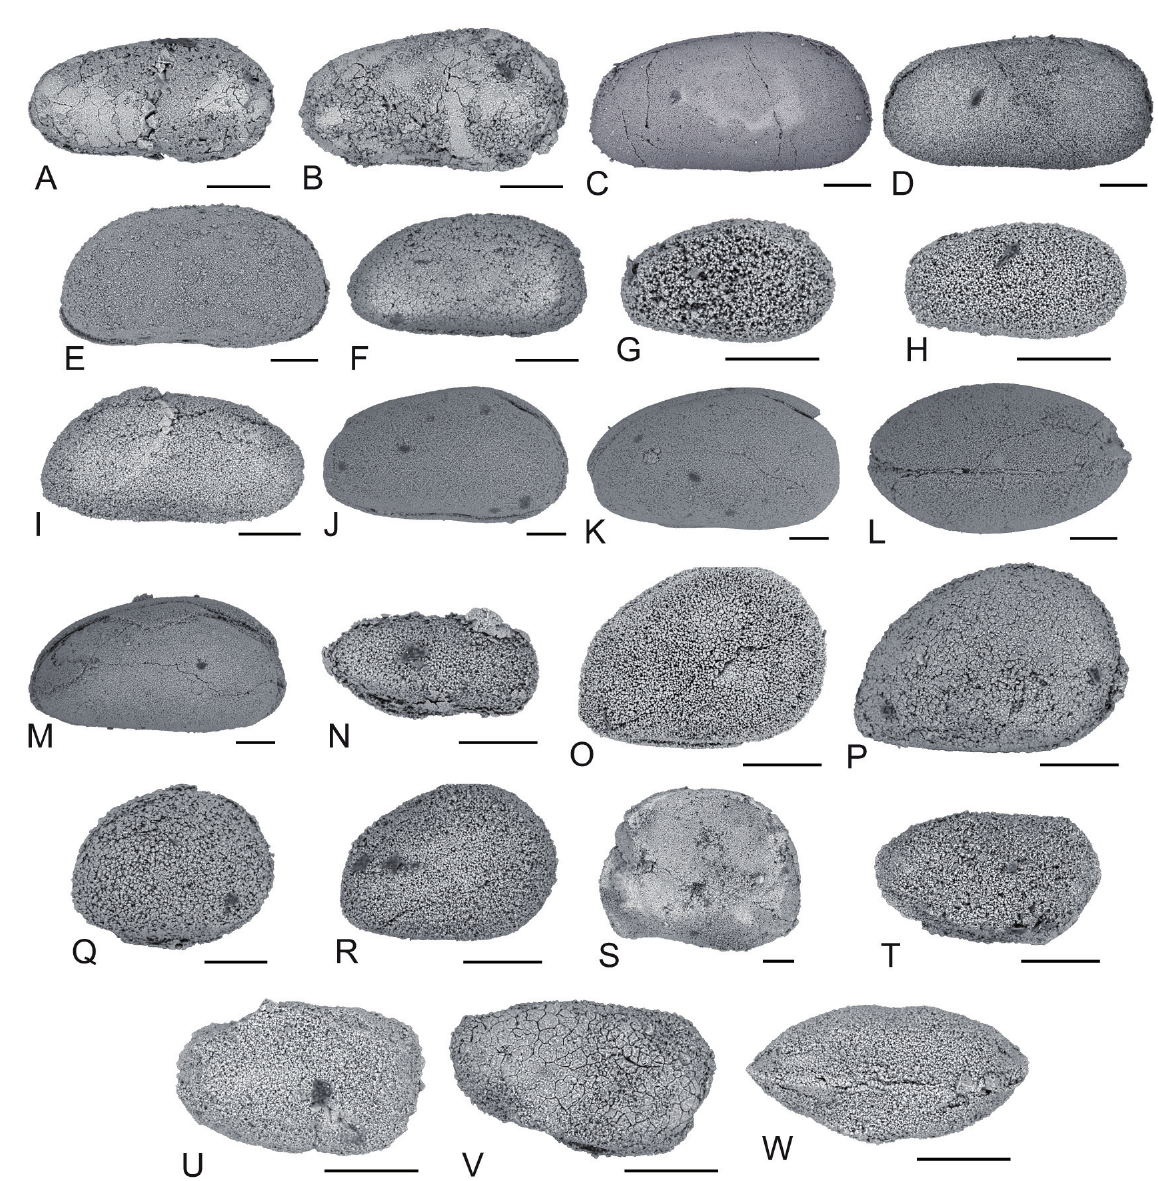
Fig. 14. Ostracods from the Dajiang section, South China. — A–B . Paracypris cf. gaetanii Crasquin– Soleau, 2006. A . Carapace, right lateral view, P6M3104. B . Carapace, right lateral view, P6M3105. — C–E . Paracypris sp. 6. C . Carapace, right lateral view, P6M3106. D . Carapace, right lateral view, P6M3107. E . Carapace, right lateral view, P6M3108. — F . Paracypris sp. 1, carapace, right lateral view, P6M3109. — G . Paracypris ? sp. 2, carapace, right lateral view, P6M3110. — H . Paracypris ? sp. 3, carapace, right lateral view, P6M3111. — I . Paracypris ? sp. 4, carapace, right lateral view, P6M3112. — J–M . Paracypris ? sp. 5. J . Carapace, right lateral view, P6M3113. K . Carapace, right lateral view, P6M3114. L . Carapace, dorsal view, P6M3151. M . Carapace, right lateral view, P6M3115. — N . Monoceratina ? sp. 1, carapace, right lateral view, P6M3116. — O–R . Basslerella tota Chen & Bao, 1986. O . Carapace, right lateral view, P6M3117. P . Carapace, right lateral view, P6M3118. Q . Carapace, right lateral view, P6M3119. R . Carapace, right lateral view, P6M3120. — S . Basslerella ? sp. 1, carapace, right lateral view, P6M3121. — T–W . Callicythere postiangusta Wei, 1981. T . Carapace, right lateral view, P6M3122. U . Carapace, right lateral view, P6M3123. V . Carapace, right lateral view, P6M3124. W . Carapace, dorsal view, P6M3125. – Scale = 100